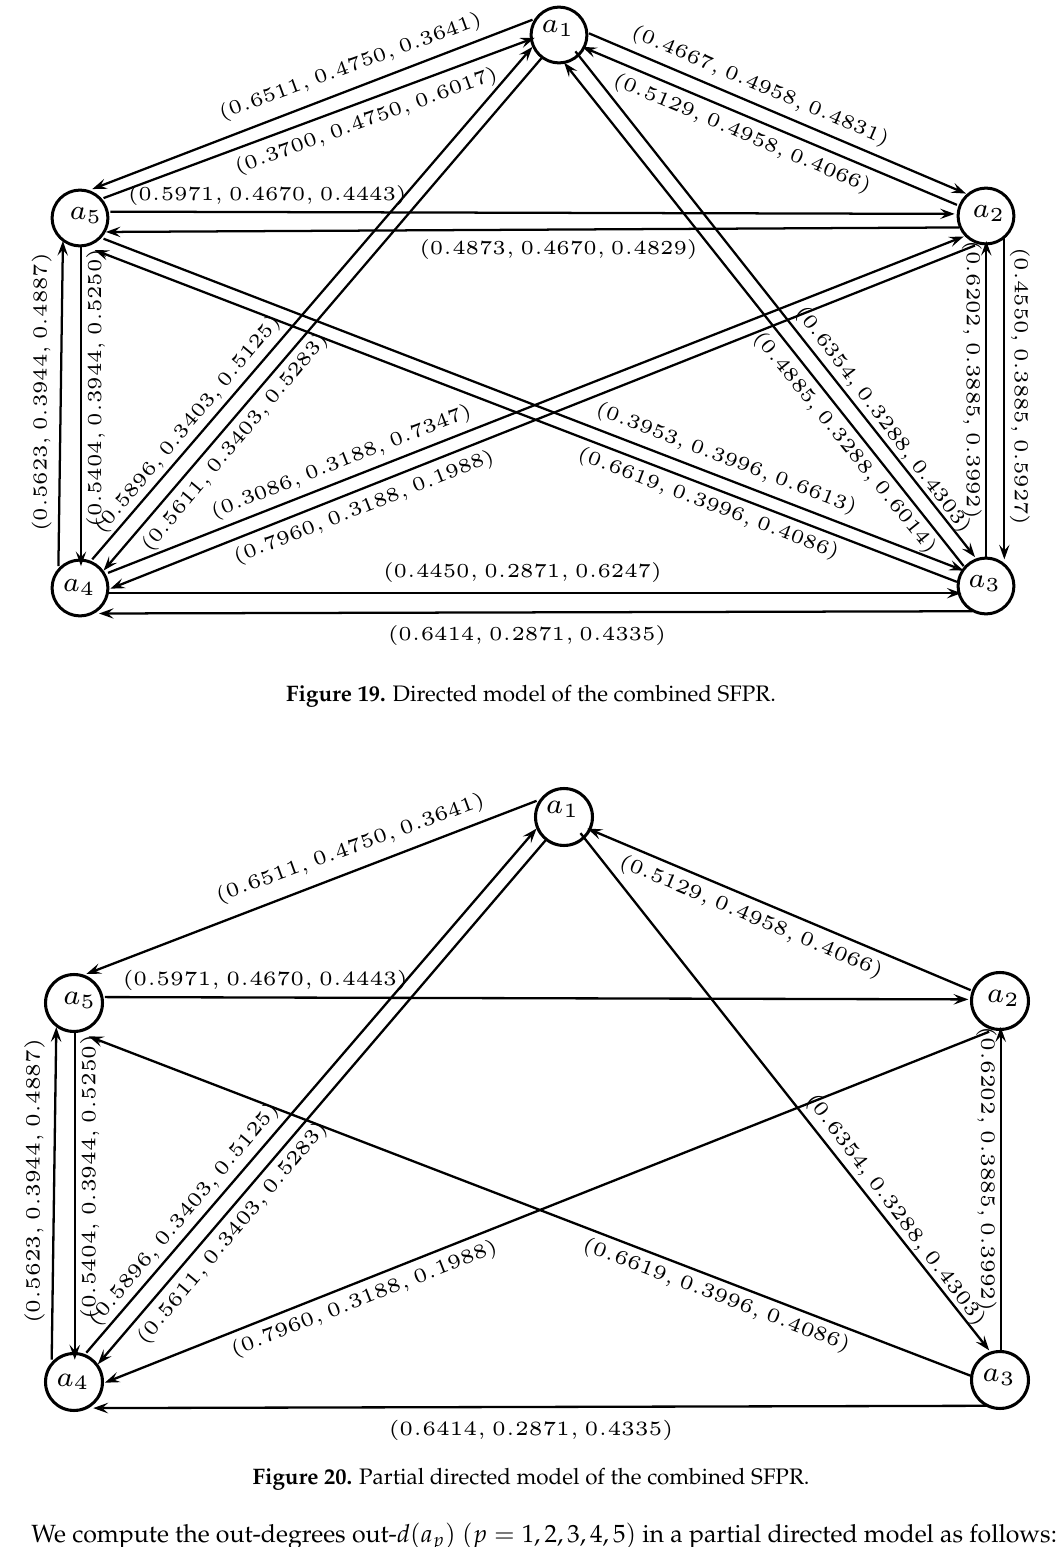
Compute the out-degrees out- d ( a out − d ( a ) = (1 . 8476 , 1 . 1441 , 1 . 3227) , out − d ( a 1 out − d ( a ) = (1 . 1519 , 0 . 7347 , 1 . 0012) , out − d ( a 4